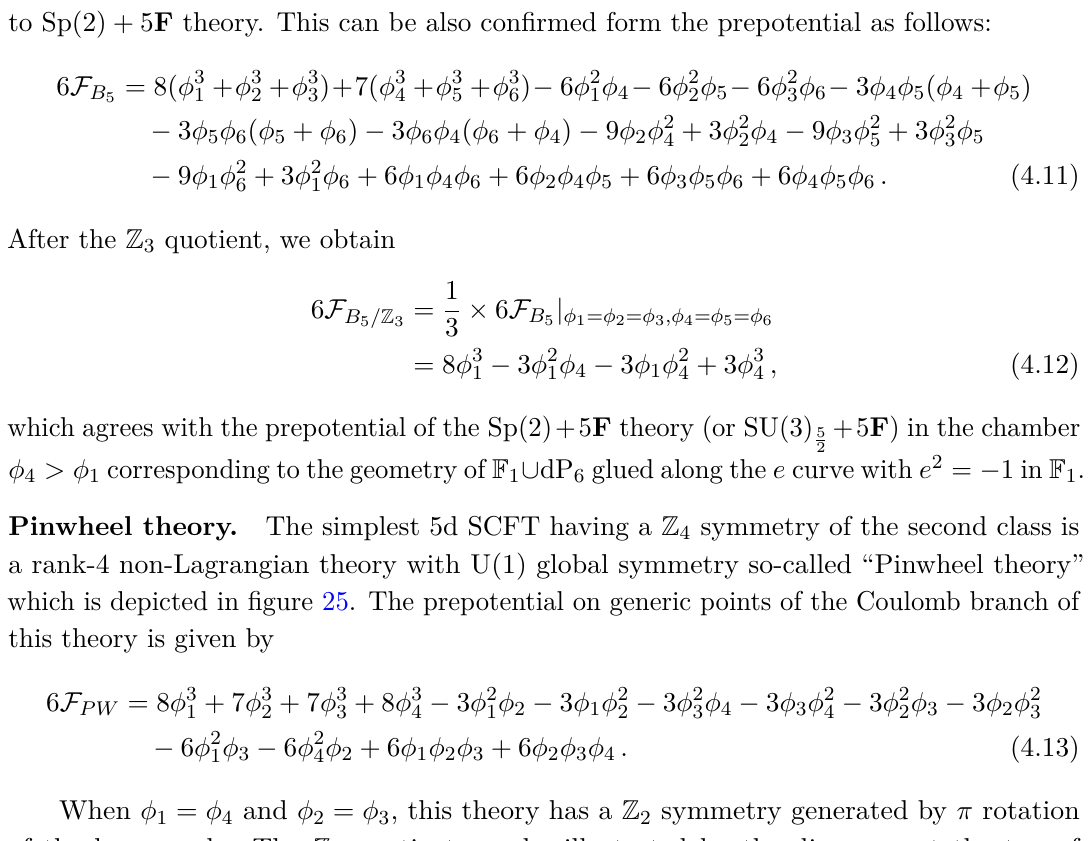
to Sp(2) + 5 F theory. This can be also confirmed form the prepotential as